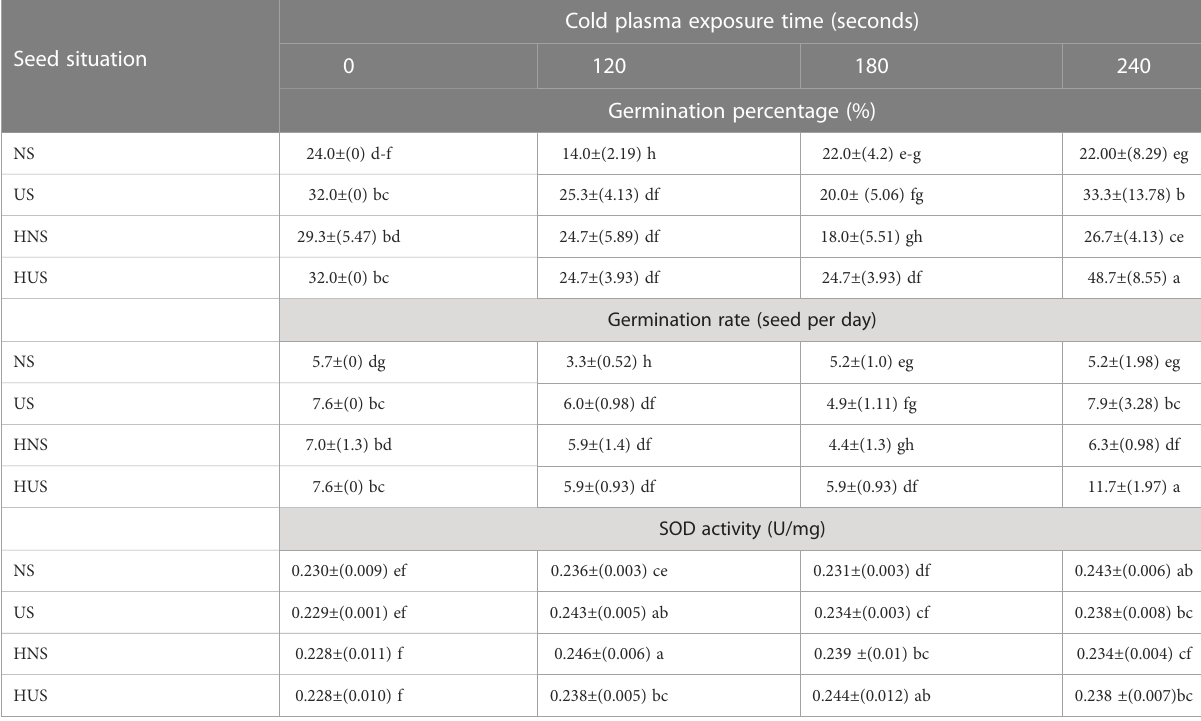
TABLE 2 The effect of seed situation and cold plasma exposure time on the germination percentage and rate and superoxide dismutase (SOD) activity of S. leriifolia seeds.